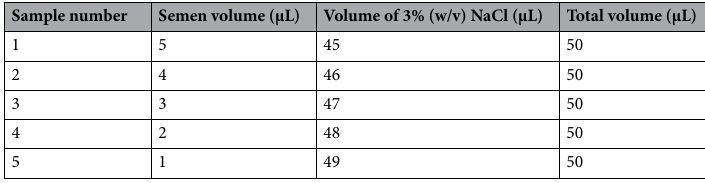
Table 2. Sample dilution of semen sample for calibration